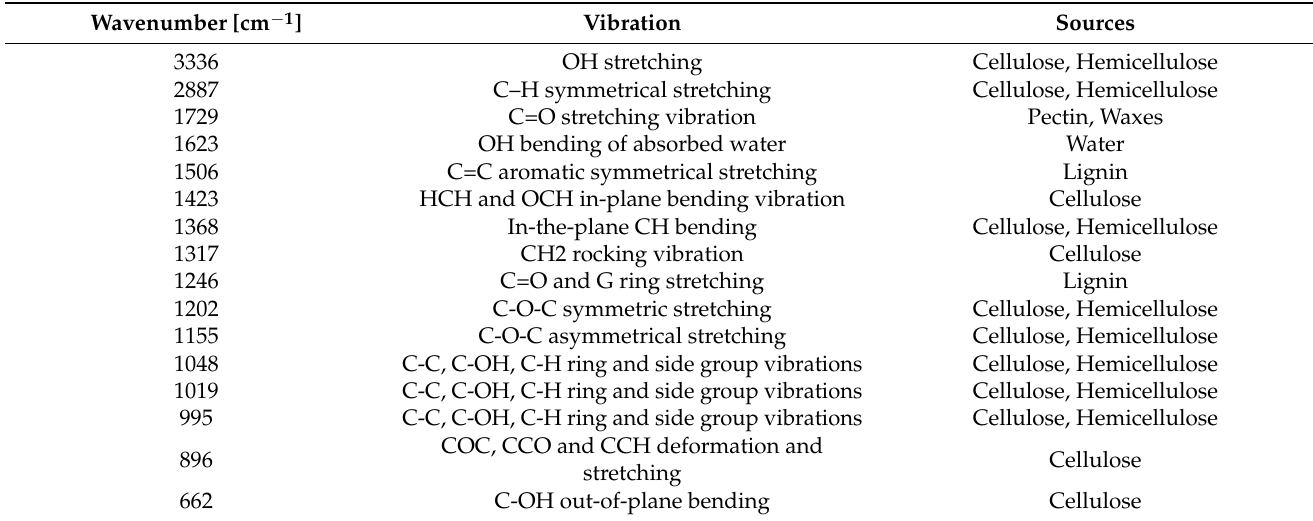
Table 2. Main infrared transition for hemp fibre